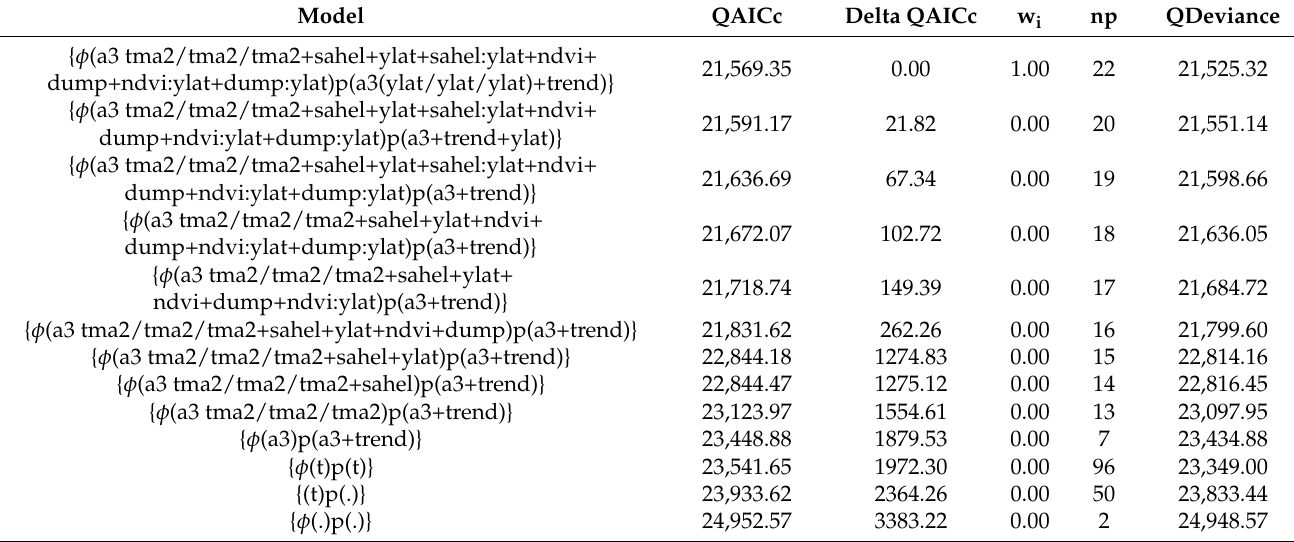
Table 2. Model selection. QAICc: Corrected AICc; wi: QAICc weights; np: number of parameters in the model; QDeviance: Corrected deviance. Estimates corrected for c-hat = 1.93 (c-hat from CJS standard model –(t) p(t))–, see Methods and Table